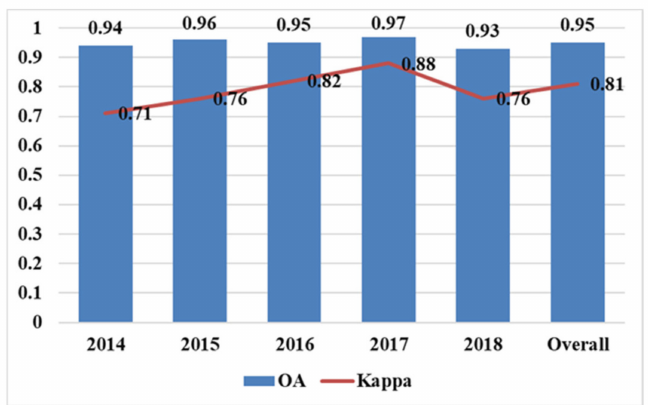
Figure 11. Accuracy assessment of the extraction results in Sansha Bay based on visual interpretation. The blue column represents the overall accuracy, and the red line represents the Kappa coefficient.